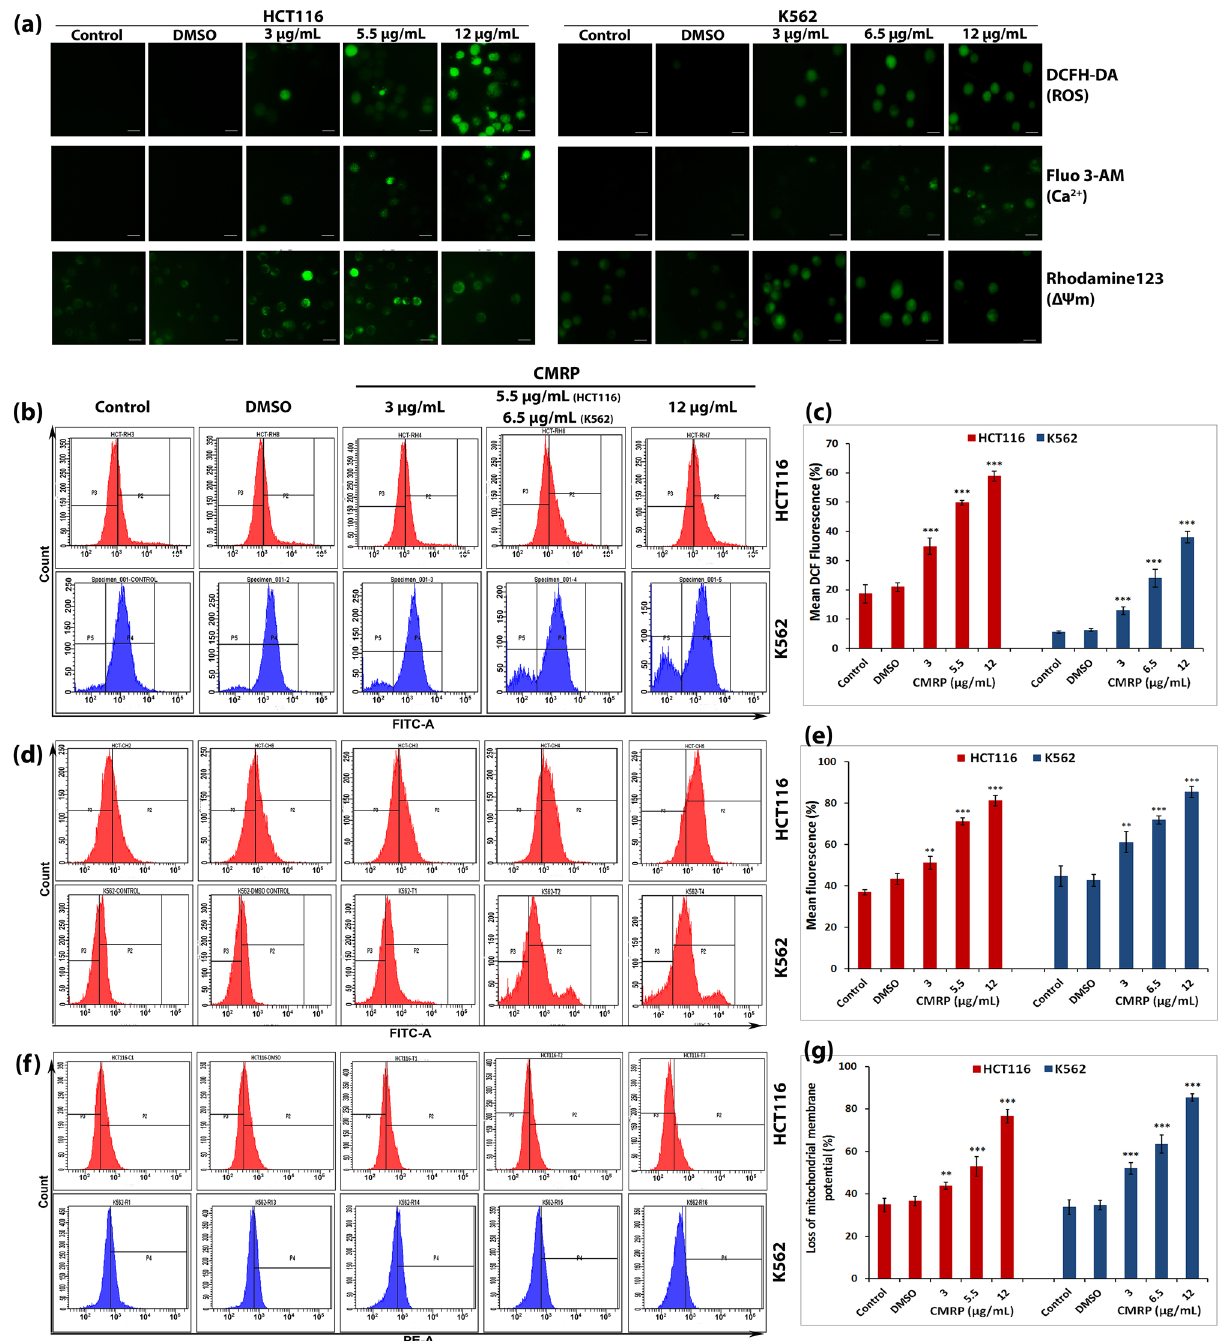
Figure 5. CMRP induces increase in intracellular ROS, Ca 2+ and loss of mitochondrial membrane potential. ( a ) Fluorescence microscopy of DCFH-DA, Fluo-3 AM and Rhodamine 123 stained HCT116 and K562 cells. ( b ), ( d ) and ( f ) flow cytometric analysis for evaluation of increase in intracellular ROS, Ca 2+ and loss of mitochondrial membrane potential respectively, while ( c ), ( e ) and ( g ) are representative histograms for mean fluorescence data obtained from flow cytometry. ** P < 0.01, *** P < variant, γ-H2AX, provided compelling and corroborative evidence of DNA damage, whilst reduction in cyclin B1 and Chk1 expression was indicative of the extract’s ability to influence the cell cycle of cancer cells. CMRP influences expression of genes essential for cell survival. RT-qPCR data obtained from HCT116 and K562cells also revealed CMRP-induced variations in the transcript levels of some of the key genes involved in cell survival, cancer progression and migration (Fig. 8c,d). Expression of mTOR and PTEN involved in PI3K/Akt/mTOR pathway was found to be affected by CMRP; at a high concentration of 12 µg/mL, mTOR